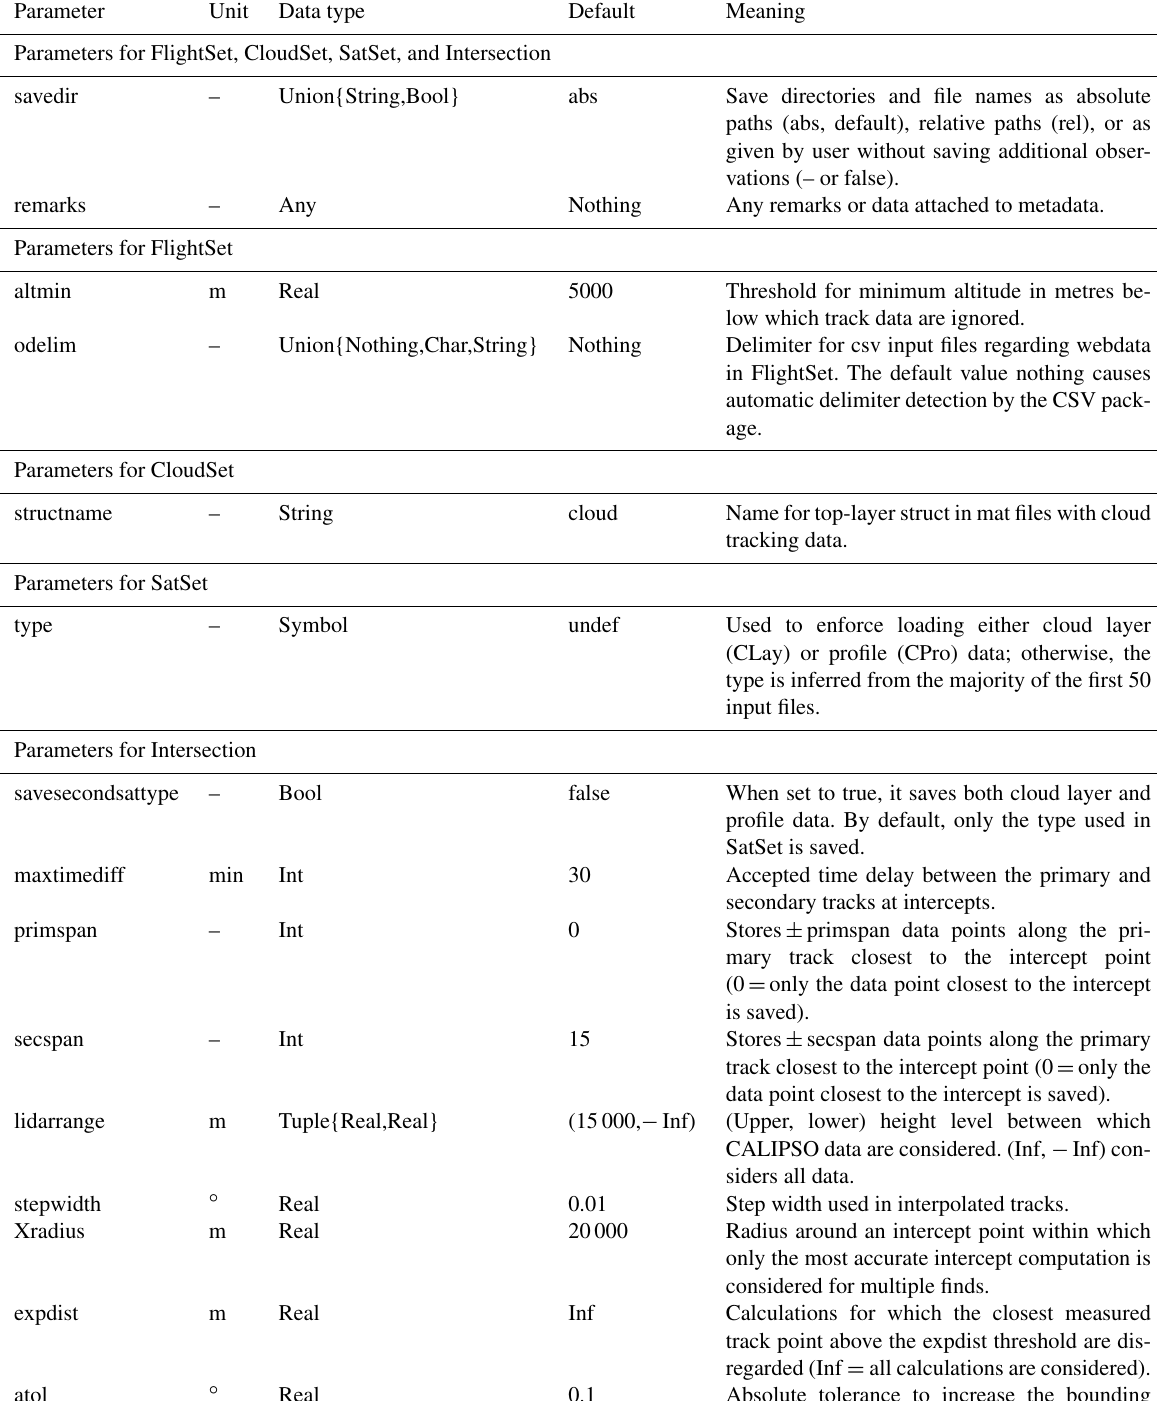
Table 1. Parameters controlling TrackMatcher runs. Arguments are printed italic, keyword arguments use roman font. Parameter Unit Data type Parameters for FlightSet, CloudSet, SatSet, and